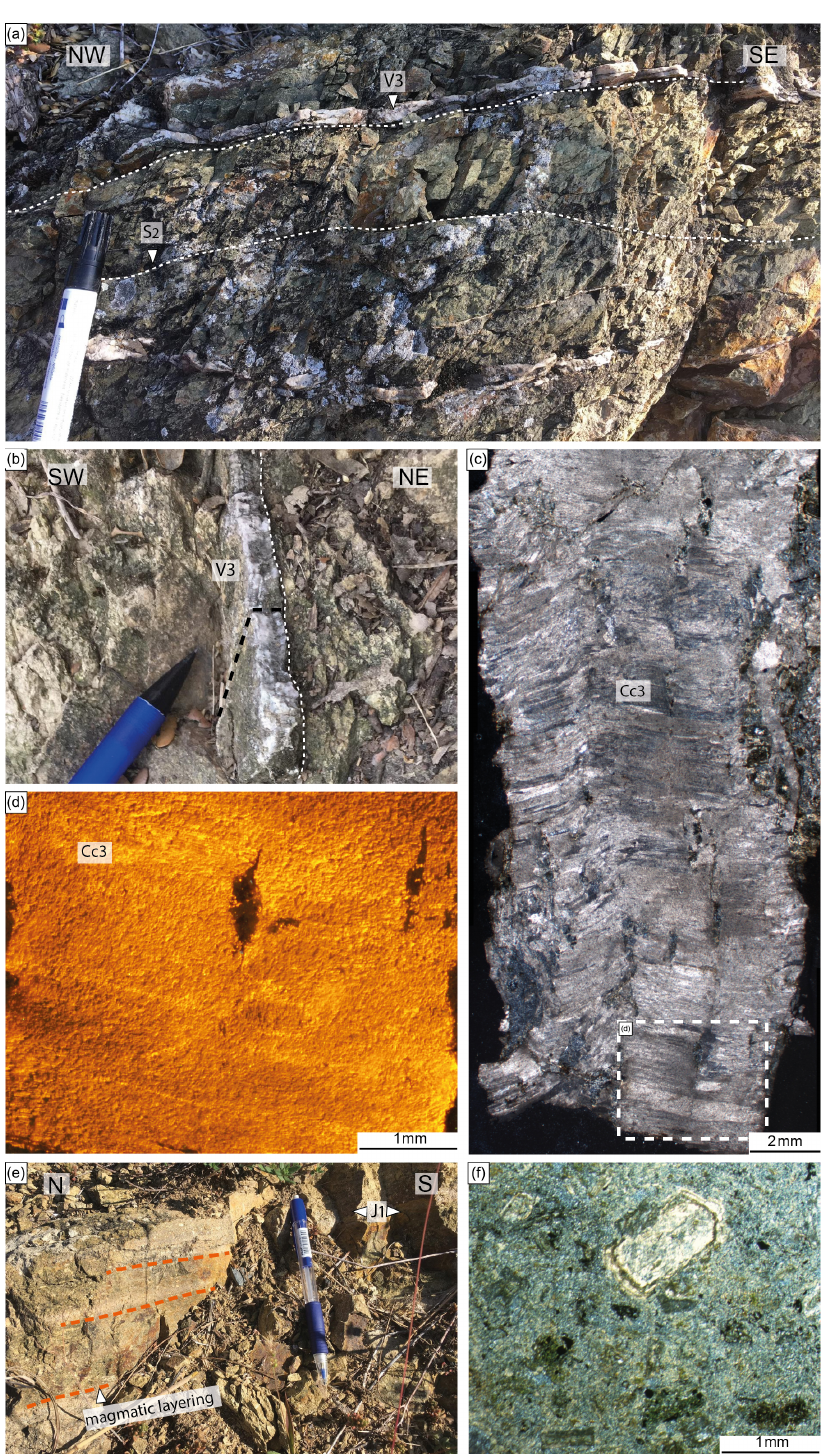
Figure 7. Mesostructures and microstructures present in the Stephano-Permian volcanic footwall. (a) Field image of the subsidiary thrust zone in the footwall showing the thrust zone foliation (S 2 ) and the veins V3. (b) Detail of veins V3, also in the subsidiary thrust zone. The black dashed line indicates the original position of the thin section observed in panel (c) . (c) Cross-polarized light and (d) cathodolu- minescence microphotographs of veins V3, characterized by calcite fibers growing perpendicular to the vein walls (Cc3). (e) Field image of the footwall andesites showing the magmatic layering and joints J1. (f) Plane-polarized light microphotograph of the volcanic andesites exhibiting a porphyritic texture with a large plagioclase